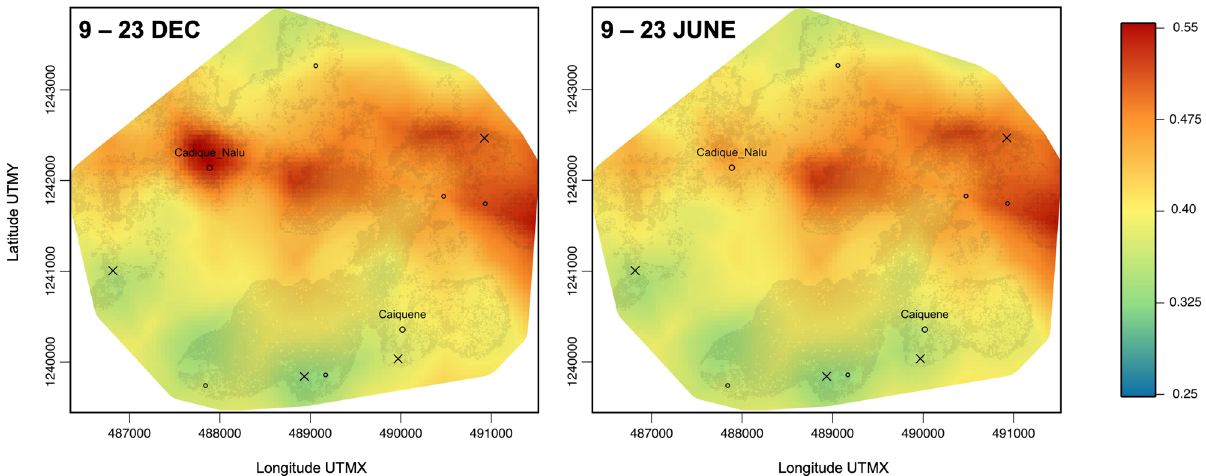
Figure 4. Predicted chimpanzee intensity of space use across their home range in Caiquene–Cadique in two time periods. December 2017 corresponded to the peak in availability of village fruits (orange, lime and papaya), June 2017 coincided with the peak in mango ripe fruit and wild fruits (Fig. 3). Circles indicate the location of villages (Cadique Nalu and Caiquene) and small settlements (unlabelled smaller circles); crosses represent abandoned villages. Prediction raster layers were created using the R package RASTER version 3.4-5 70 . Figures were created using QGIS (https ://www.qgis.org). See Movie S1 for predictions of chimpanzee intensity of space use across the 12-month study